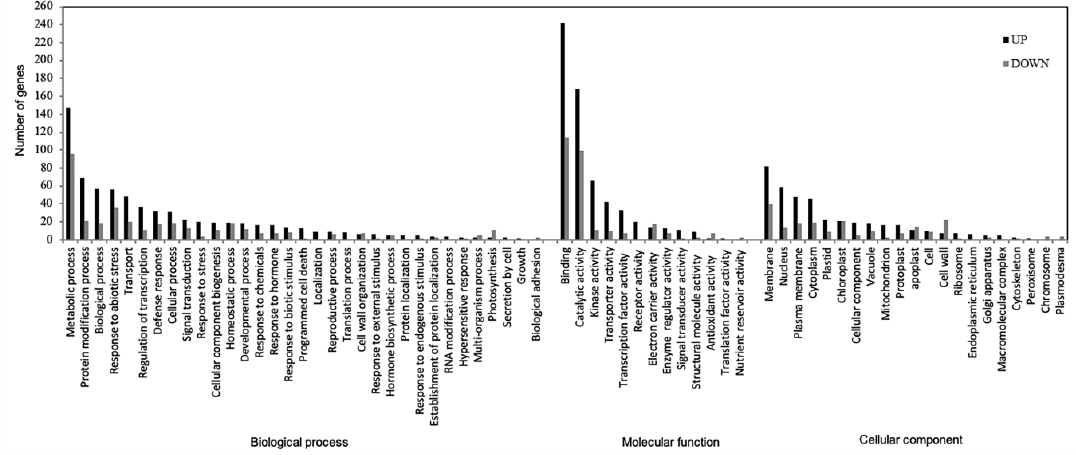
Figure 4. GO term classification of overlapping DEGs categorized into three main groups, including Biological process, Molecular function, and Cellular component. Dark bar represents up-regulation; gray bar represents down-regulation. Table 1. Representative term of most enriched annotation group ( p ≤ 0.05) determined by functional annotation clustering in DAVID.